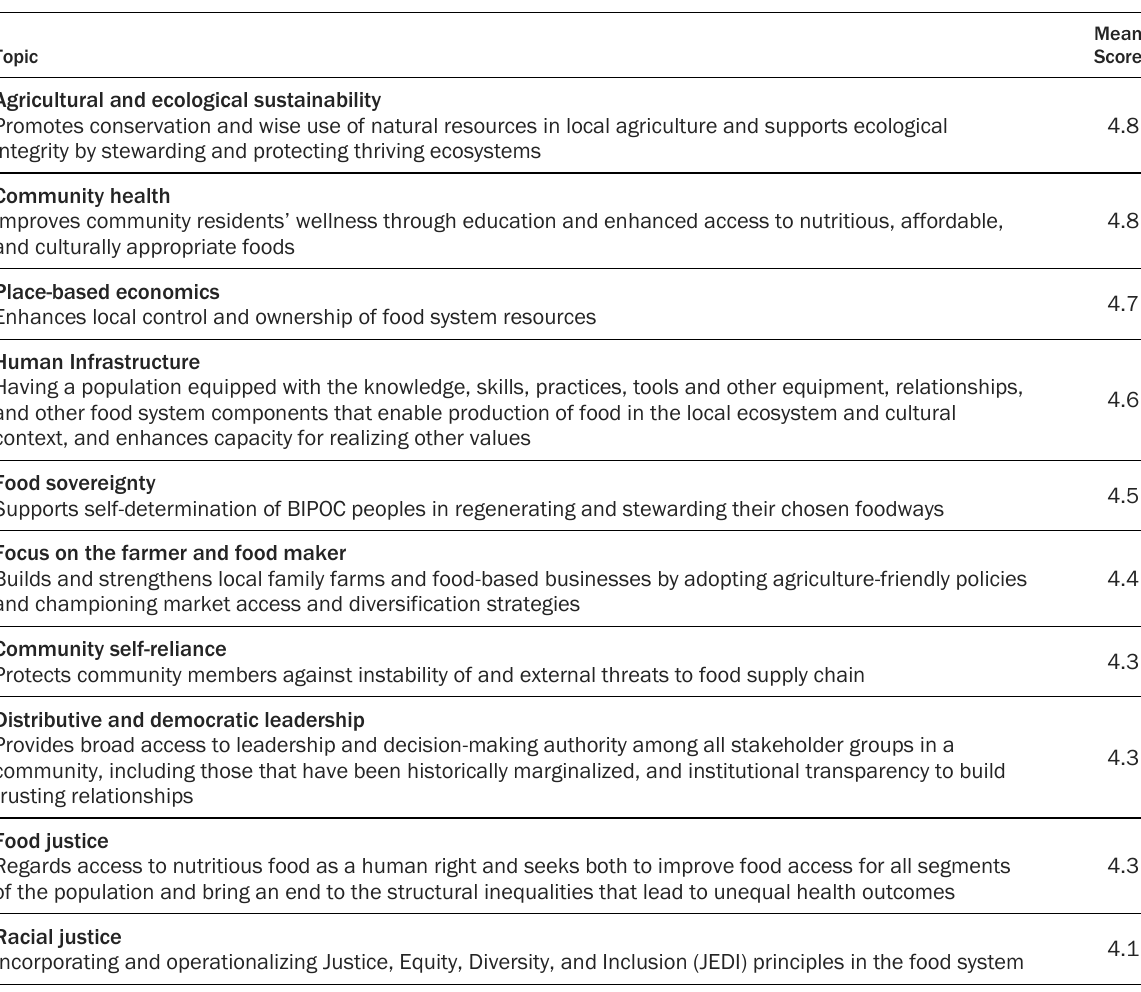
Table 2. Core Values Guiding Community Food Systems Policies and